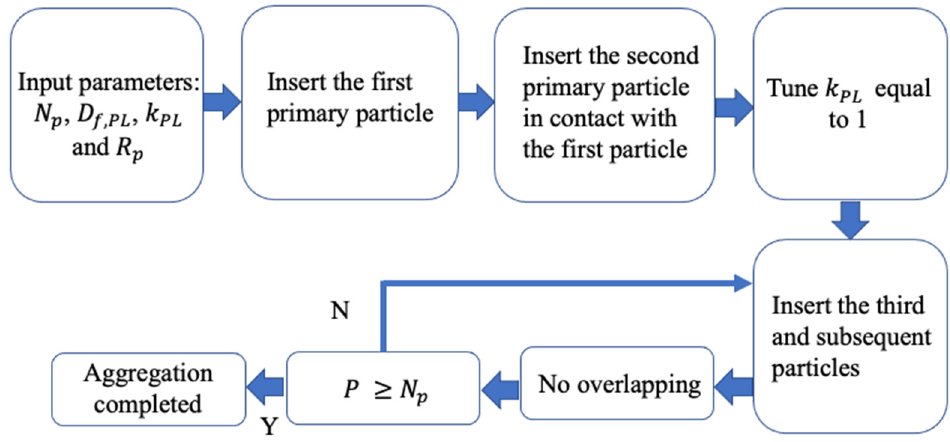
Figure 3. Flowchart of the MPTSA model.